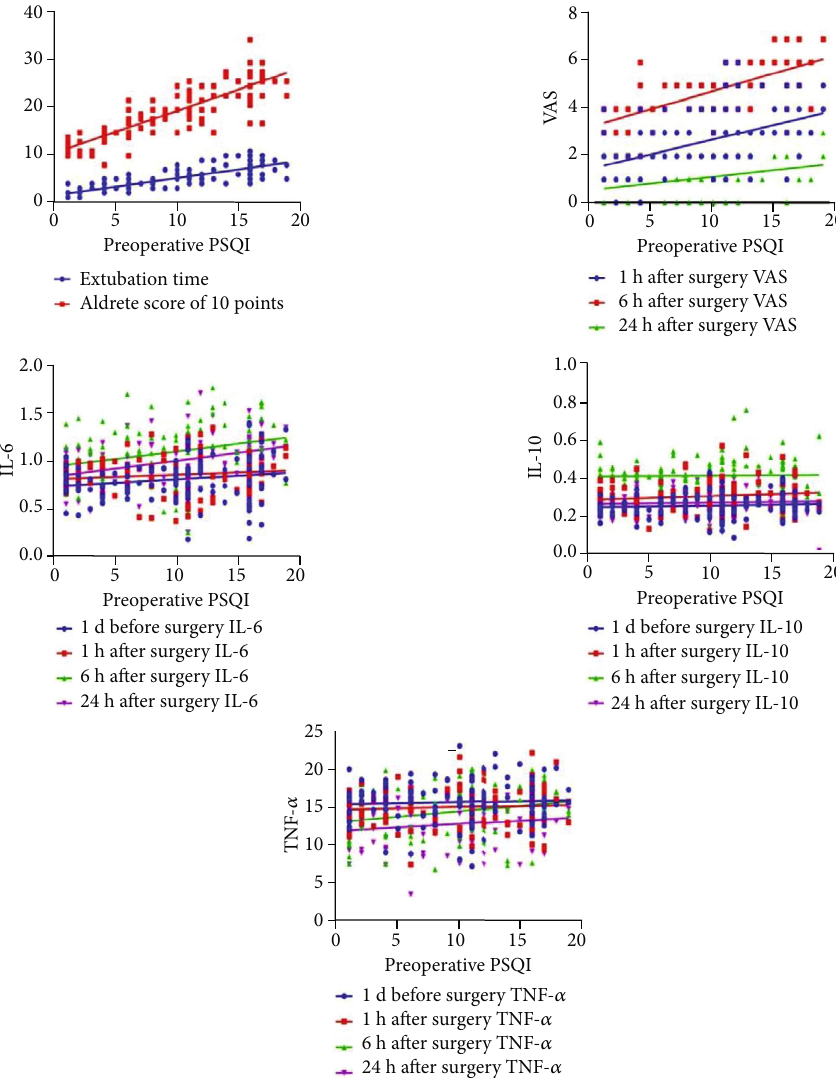
Figure 4: Correlation between each indicator and preoperative PSQI